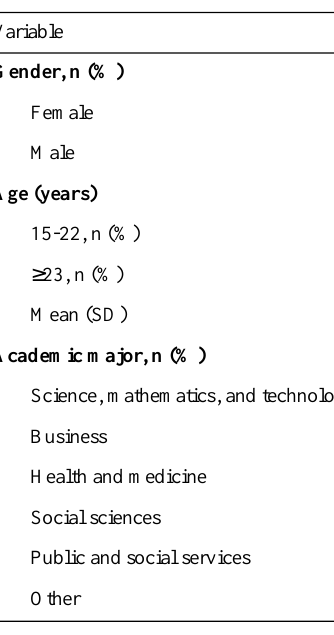
Table 4. Characteristics of the study participants